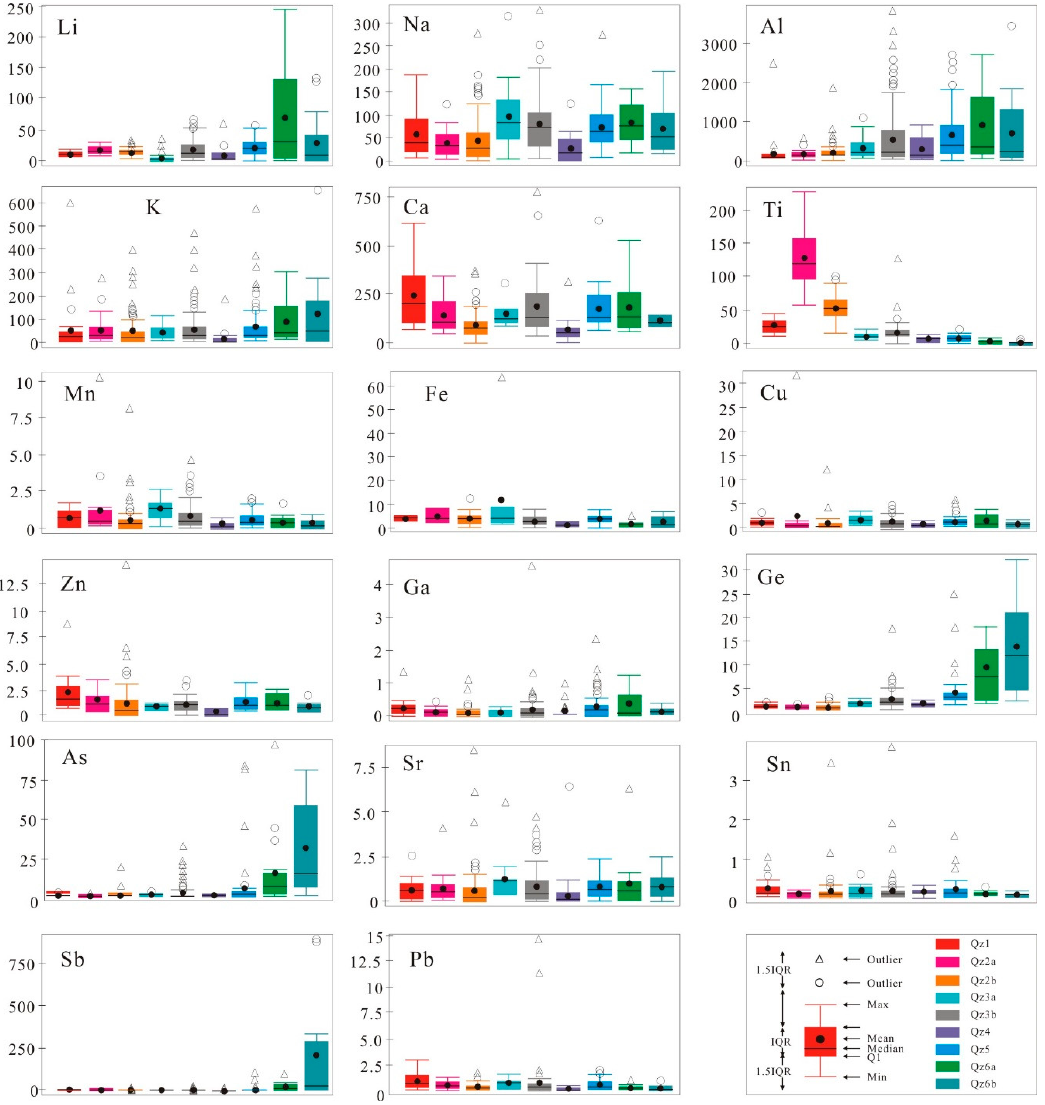
Figure A2. Tukey Boxplot of trace elements in vein quartz of the Tongchang porphyry Cu deposit.